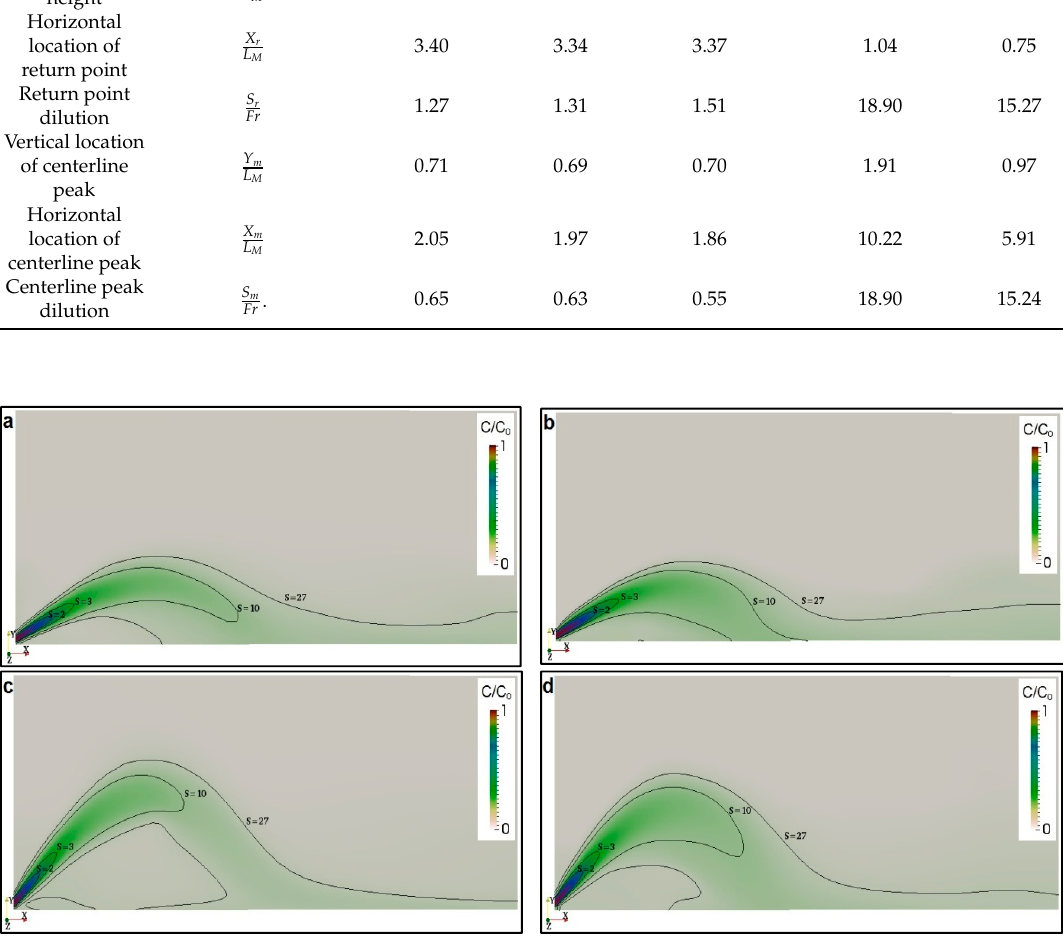
Figure 5. Discharge growth width at various cross-sections: the contour lines represent S = C 0 /C = 1 (Source: [25]). ( a ) 30°, realizable k- ε ; ( b ) 30°, LRR; ( c ) 45°, realizable k- ε ; ( d ) 45°, LRR.